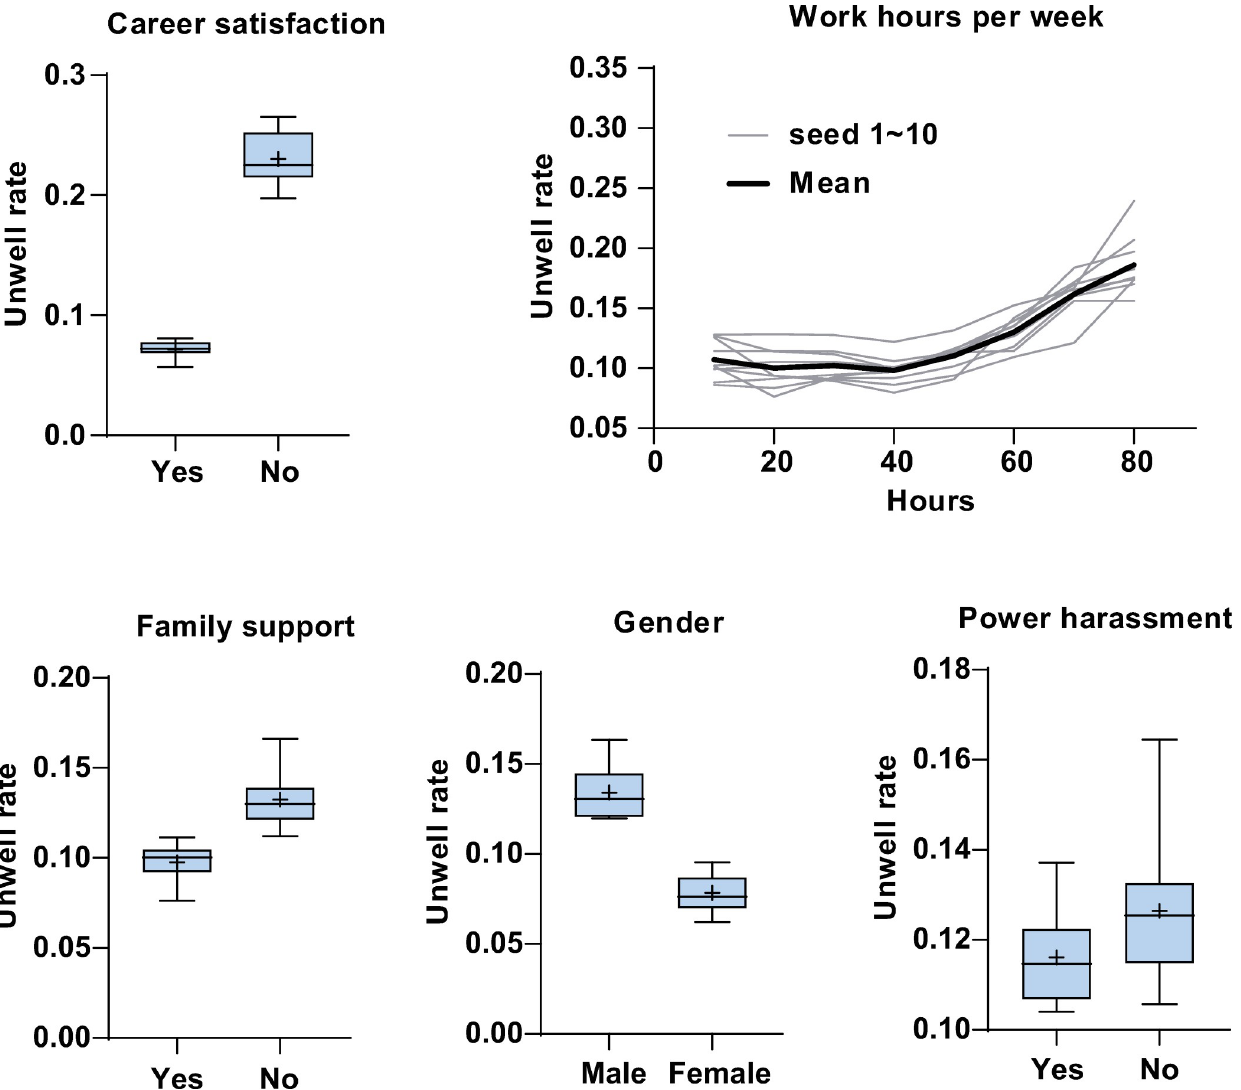
Fig 2. Effect of variable on physician well-being. Partial dependence on physician unwell state was shown for selected covariates: career satisfaction, work hours per week, family support, gender, and power harassment. Boxplots represents median, interquartile range, and extreme values. + indicates mean value. Unwell rate indicates predicted probability of unwell